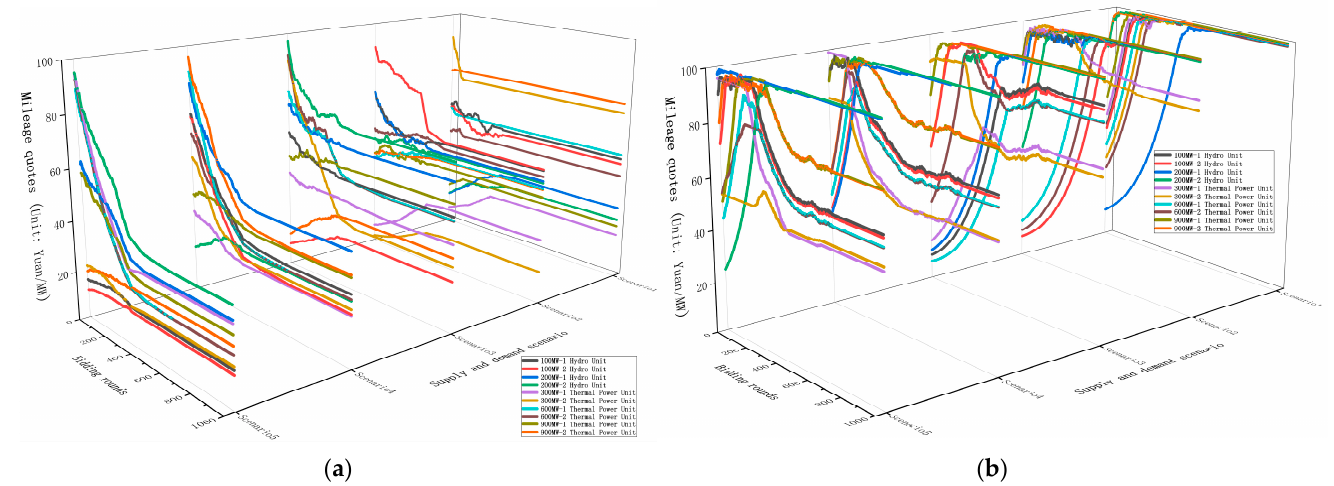
Figure 4. Evolution of unit o ff er when MCP ( a ) and PAB ( b ) are adopted in Sichuan.